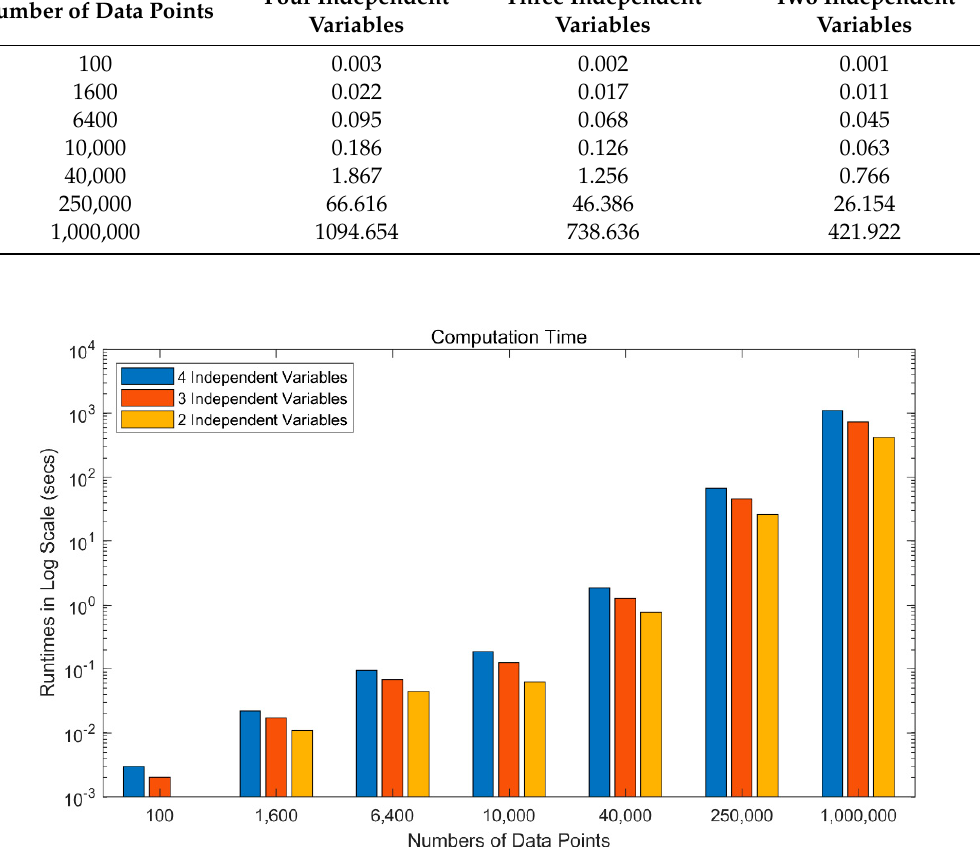
Figure 4. Runtime comparison (bar) for different numbers of coefficients using different numbers of data points.